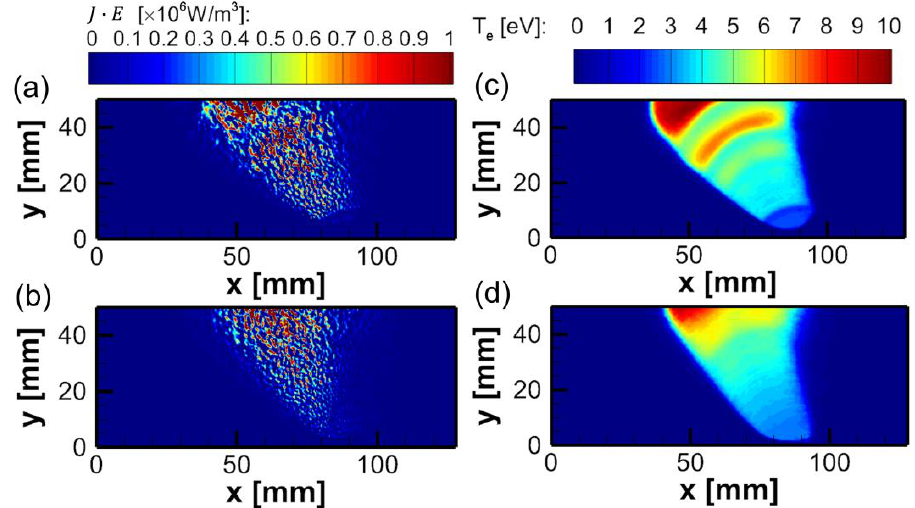
Figure 4. Profiles of 𝐽 ∙ 𝐸 with the maximum magnetic flux densities of ( a ) 350 G and ( b ) 500 G. Profiles of electron temperature with the maximum magnetic flux densities of ( c ) 350 G and ( d ) 500 G .